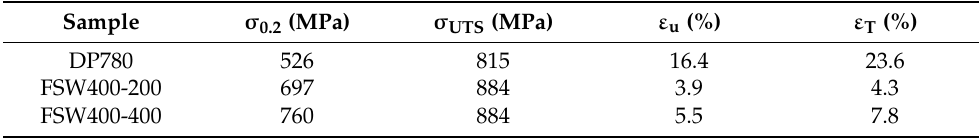
Table 3. Tensile properties of DP 780 steel and FSWed